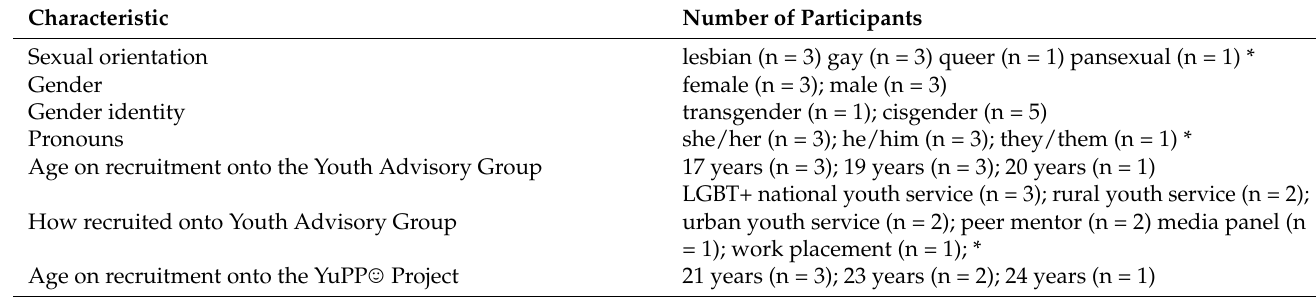
Table 2. Participant